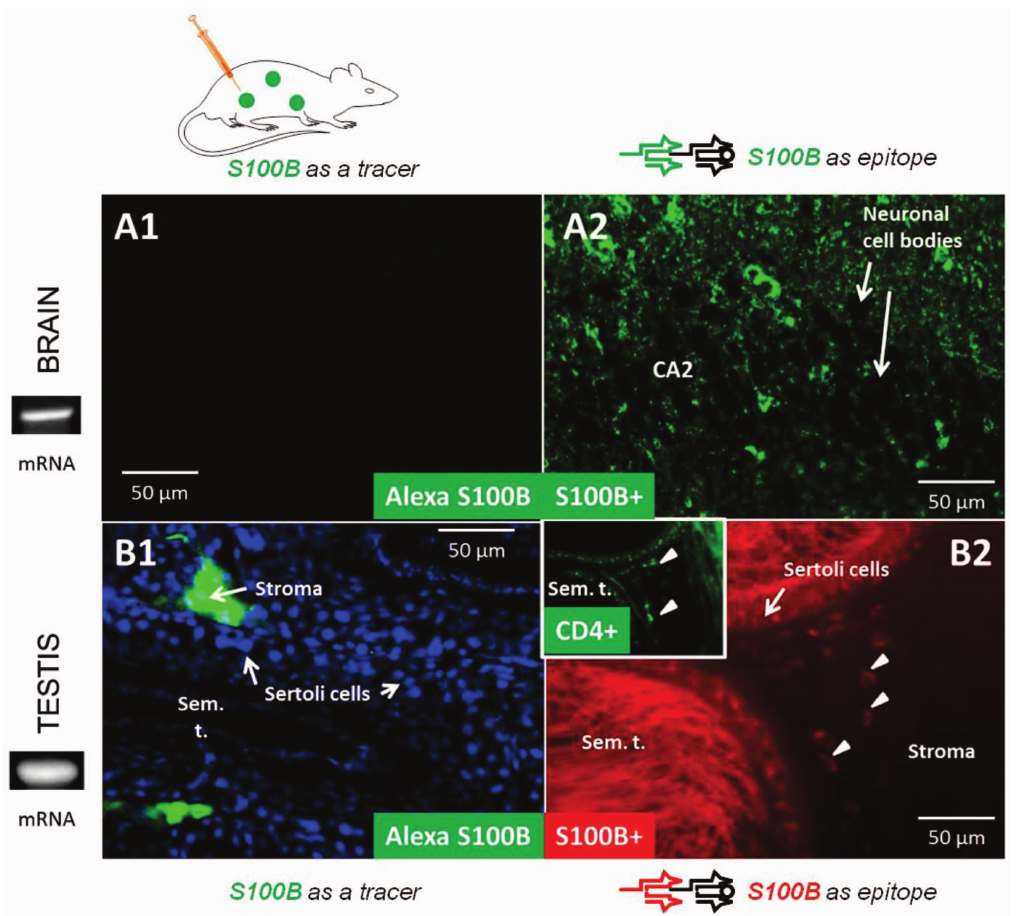
Figure 3. Circulating S100B fails to invade barrier organs; however S100B gene transcription and protein synthesis occurs in both brain and testis. Injection (exogenous) strategies demonstrate privilege of barrier organs to transendothelial diffusion of S100B while immunodetection of endogenous S100B demonstrates brain- and testis specific S100B protein by astrocytes and Sertoli cells. mRNA detection in the same barrier organs confirms S100B expression. (A1) shows the lack of fluorescent signal (Alexa Fluor (AF) 488, in green ) in brain regions where endogenous S100B was readily detected (A2) . The section used for immunohistochemistry contained the CA2 sector of the hippocampus. Note that, as expected, S100B was present in glial cells but not in neurons; neuronal cell bodies in hippocampal CA2 region are seen as unstained ghosts. Testicular tissue yielded similar results albeit in testis the barrier is established by Sertoli and not endothelial cells (B1 and B2) . Note that intravascular S100B was restricted to the stroma of the seminiferous tubules in the testis where endogenous S100B was not present. S100B + cells in the stroma ( arrowheads ) are CD4 + dendritic cells ( insert in B2 ). DAPI ( blue ) was added as a nuclear stain (B1) . AlexaFlour 488-tagged S100B was injected to mimic blood-brain barrier disruption (e.g., ref. 13). The labeled protein was allowed to circulate 3 hrs. prior to tissue harvesting. The mRNA bands shown reflect levels of expression by brain and testis. Sem. T. = seminiferous tubule .